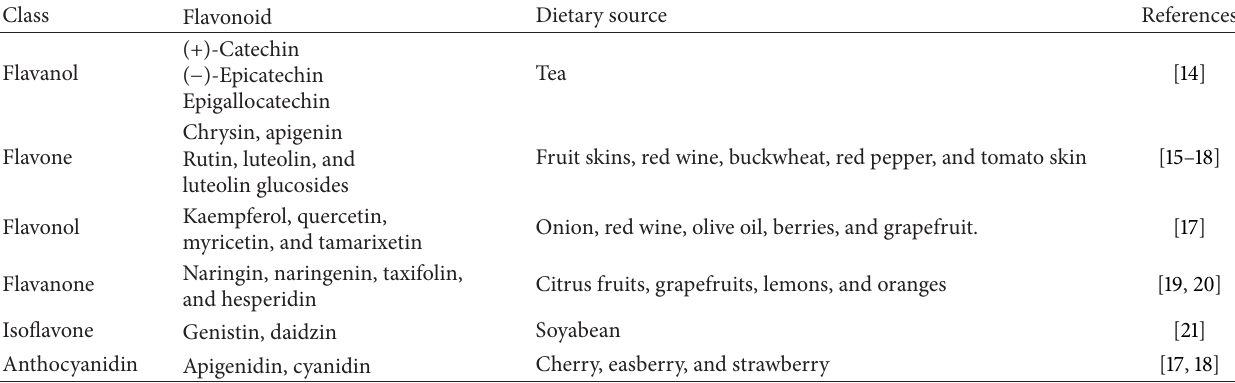
Table 2: Classification, structure, and food sources of some dietary flavonoids.